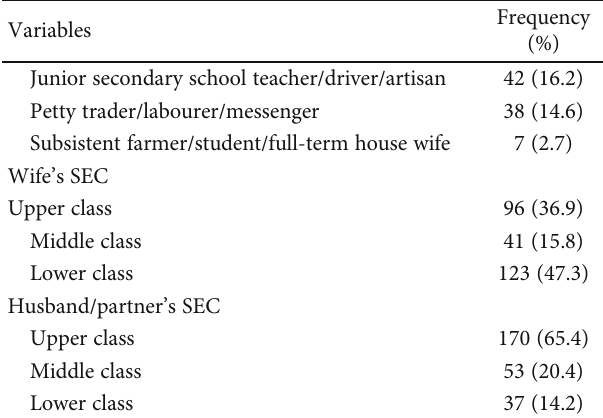
Table 1: Sociodemographic characteristics of